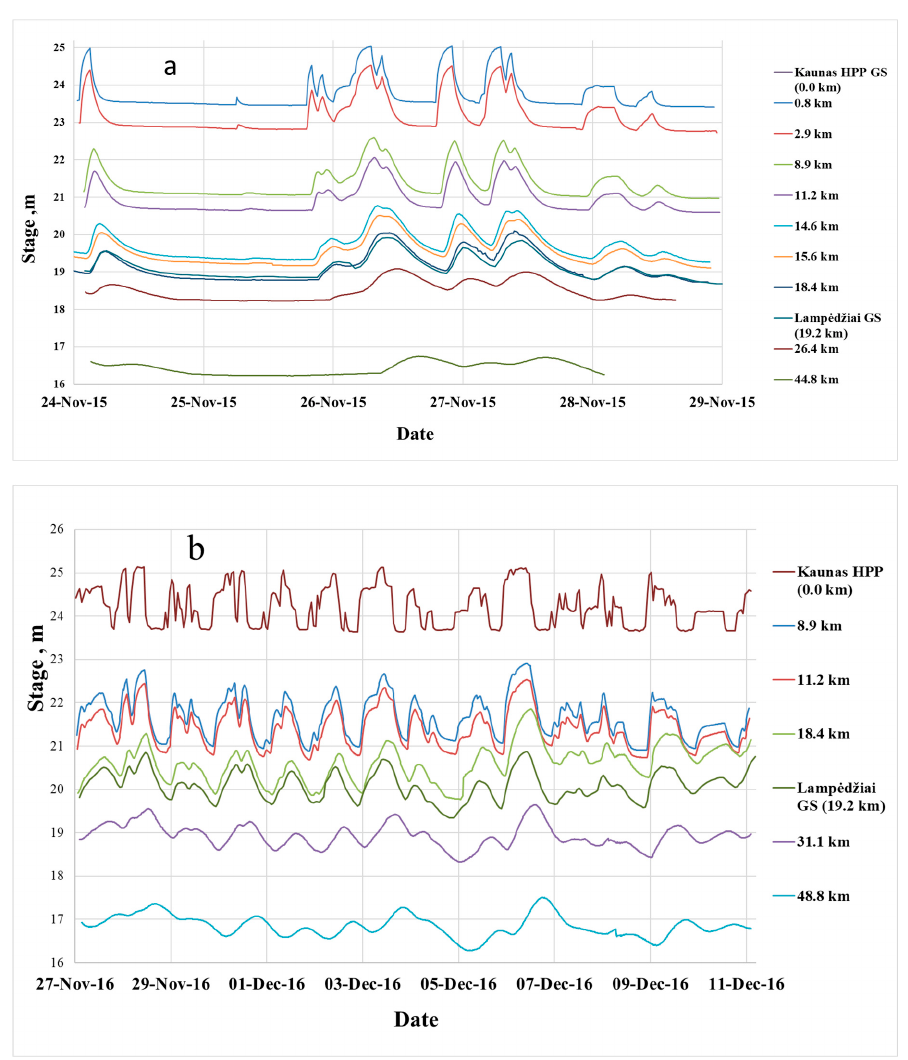
Figure 8. Stage measurements along the Nemunas River downstream from Kaunas HPP: ( a ) Low flow period (return period 20 years), ( b ) mean flow period (return period 2 years).